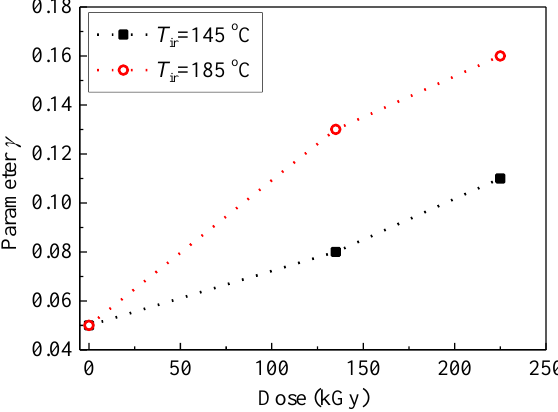
Figure 5. Parameter γ as a function of dose irradiated at temperatures T ir of 145 and 185 °C.